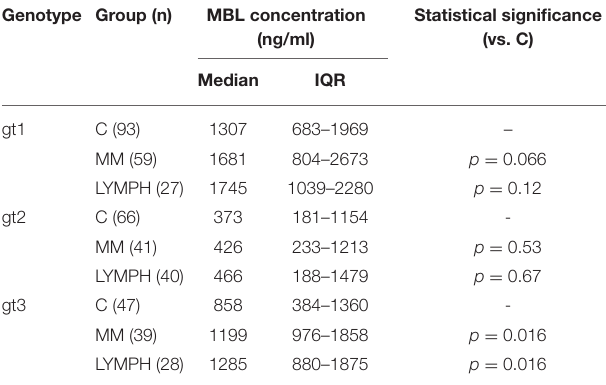
TABLE 5 | Serum MBL concentrations in controls and patients (sample 1), corresponding to most common MBL2 genotypes (basing on 3 ′ -UTR